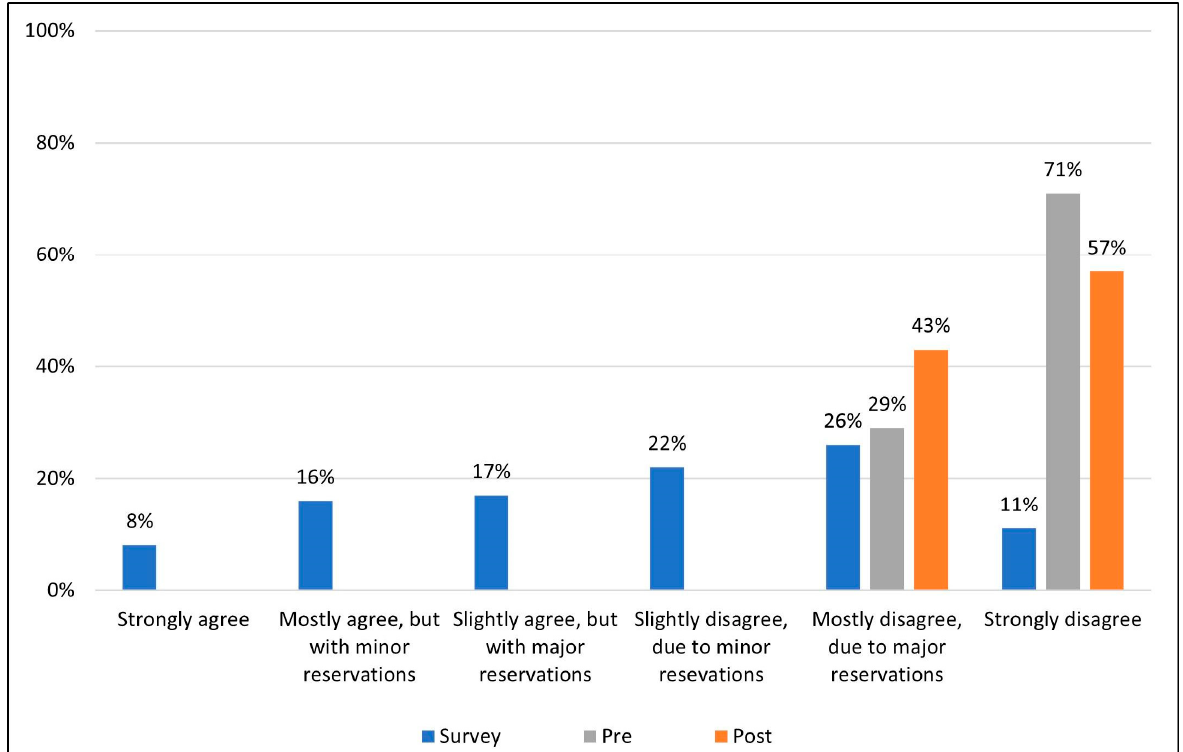
Figure 1 . Level of acceptance/rejection for field survey respondents and the expert panel pre- and post-presentation of evidence . The 508 survey respondents voted on their level of acceptance or rejection of the statement based on a 6-point Likert scale (blue). Prior to seeing field survey results, and discussing the literature, the 7 members of the appraisal panel voted on their level of ac- ceptance/rejection (gray). The literature and data supporting and refuting the statement were then reviewed, discussed and the same 7-member panel voted once more (orange) on their levels of ac- ceptance /rejection using the same 6-point Likert scale.